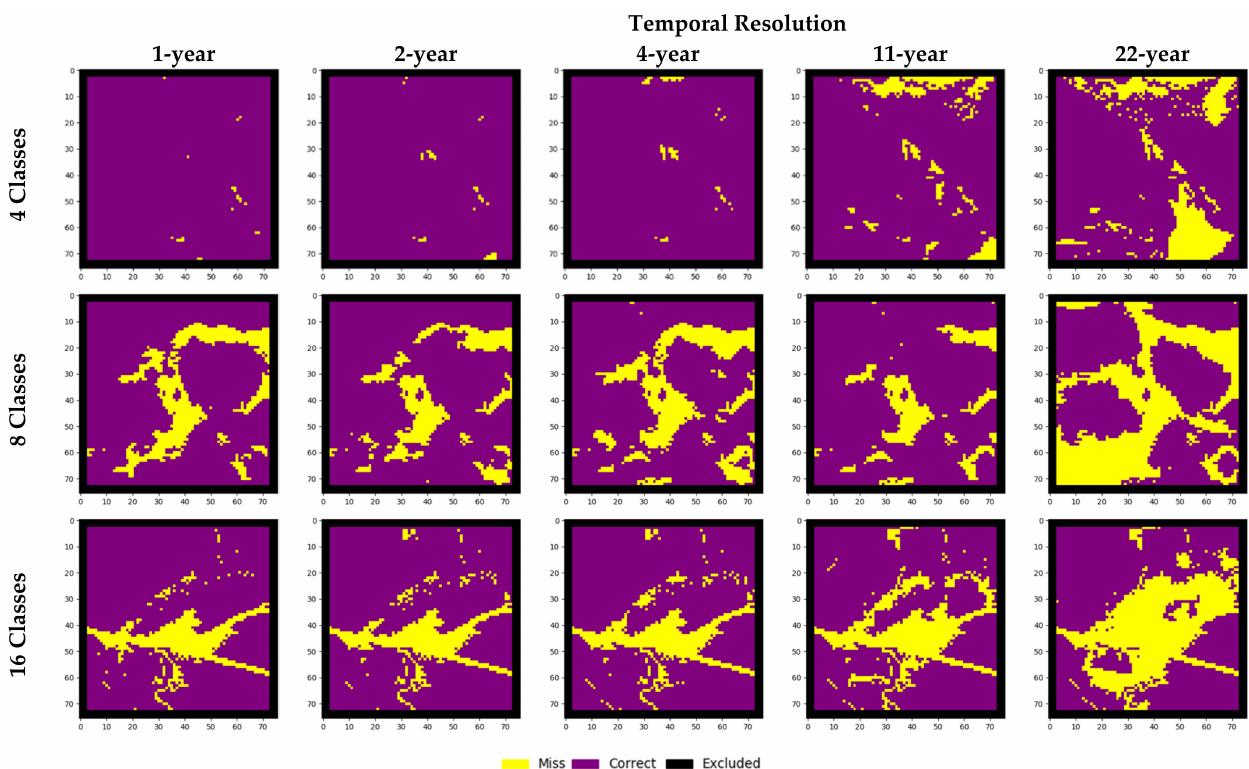
Figure 6. Forecasting errors in results of experiments run with the 45-year hypothetical LC datasets with 4, 8, and 16 classes.